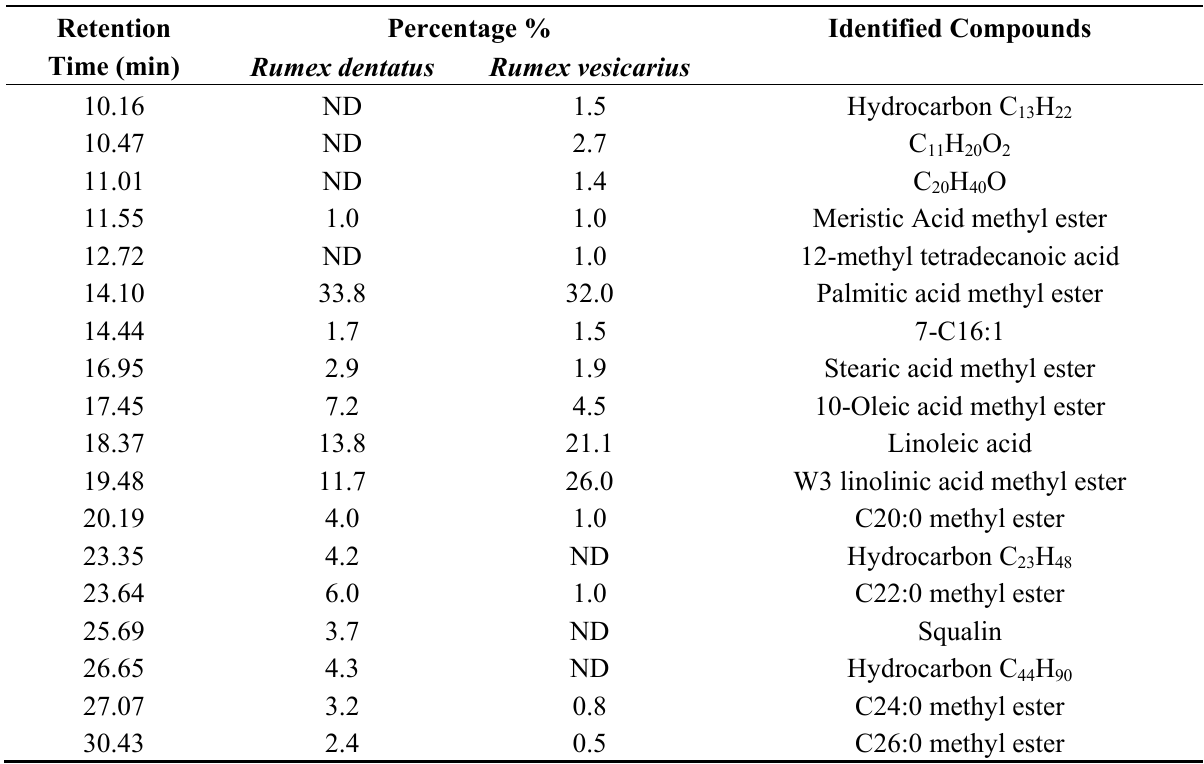
Table 2. Fatty acids methyl esters composition of Rumex dentatus and Rumex vesicarius